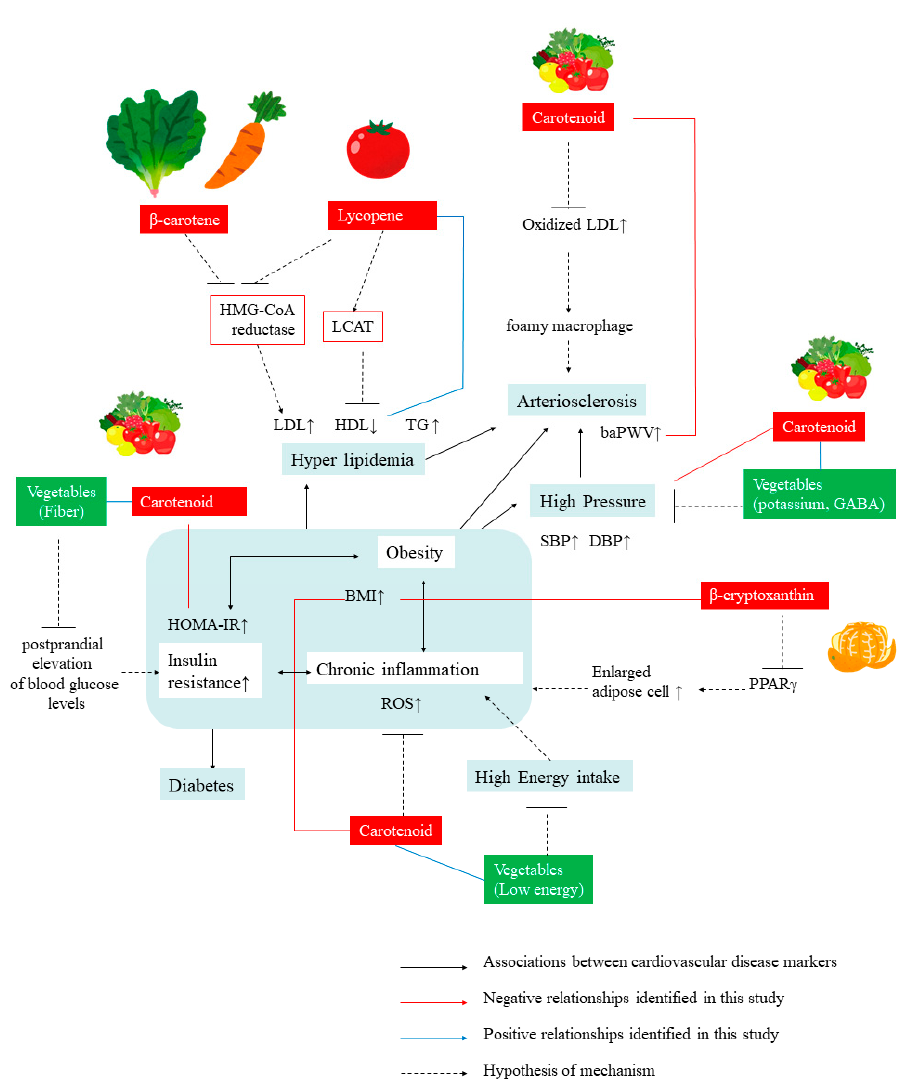
Figure 1. Diagram depicting roles played by carotenoids from vegetable intake on the prevention of cardiovascular diseases. BMI, body mass index; baPWV, brachial ankle pulse wave velocity; SBP, systolic blood pressure; DBP, diastolic blood pressure; HOMA-IR, Homeostatic Model Assessment for Insulin Resistance; FBG, fasting blood glucose; TG, triglyceride; HDL, high-density lipoprotein cholesterol; LDL, Low-density lipoprotein cholesterol; HOMA-IR, Homeostatic Model Assessment for Insulin Resistance; GABA, γ -aminobutyric acid; HMG-CoA reductase, 3-hydroxy-3-methylglutaryl-coenzyme A reductase; LCAT, Lecithin–cholesterol acyltransferase; PPAR γ , Peroxisome proliferation-activated receptor gamma; ROS, reactive oxygen